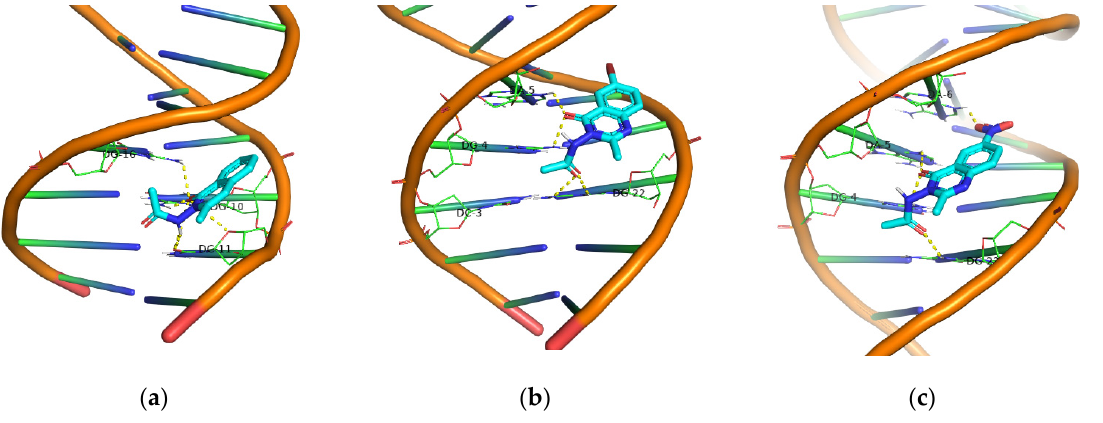
Figure 7. Panel ( a ): Molecular docking calculations for compound 4 ; Panel ( b ): Molecular docking calculations for compound 6 ; panel ( c ): Molecular docking calculations for compound 8 .